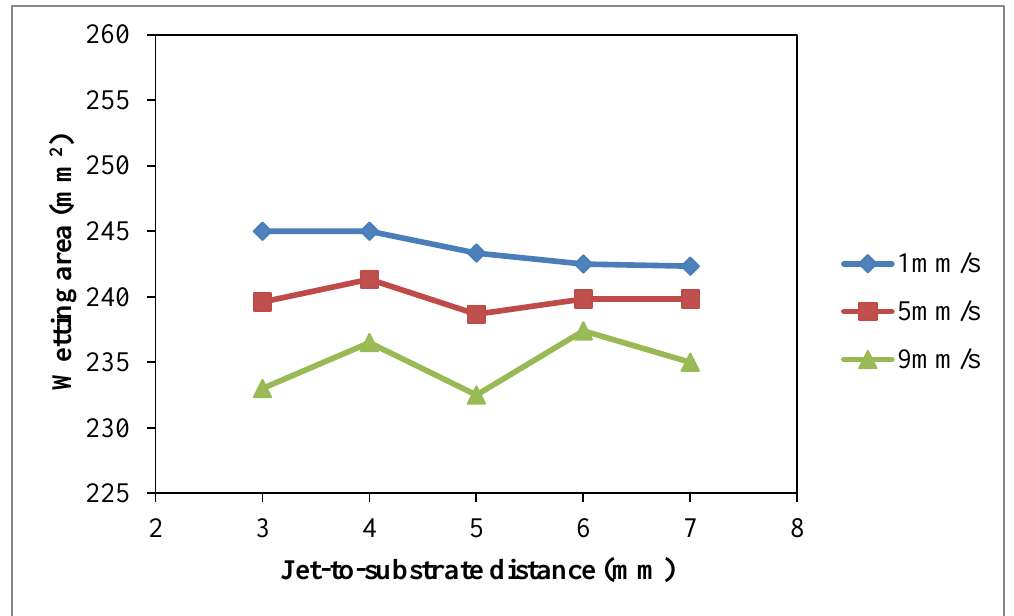
Figure 17. Effect of jet-to-substrate distance wetting area W c (Jet-to-substrate distance: 3 mm, 4 mm, 5 mm, 7 mm and 9 mm; Jet travelling speed: 1 mm/s, 5 mm/s, 9 mm/s; Discharge power: 150 W and Oxygen flow rate: 0.4 L/min).